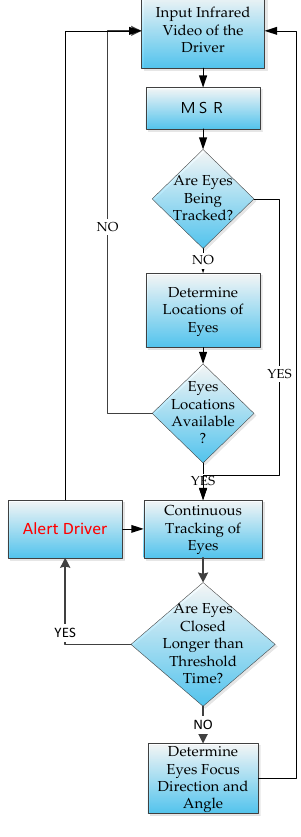
Figure 1. The flowchart for the driver attention component.